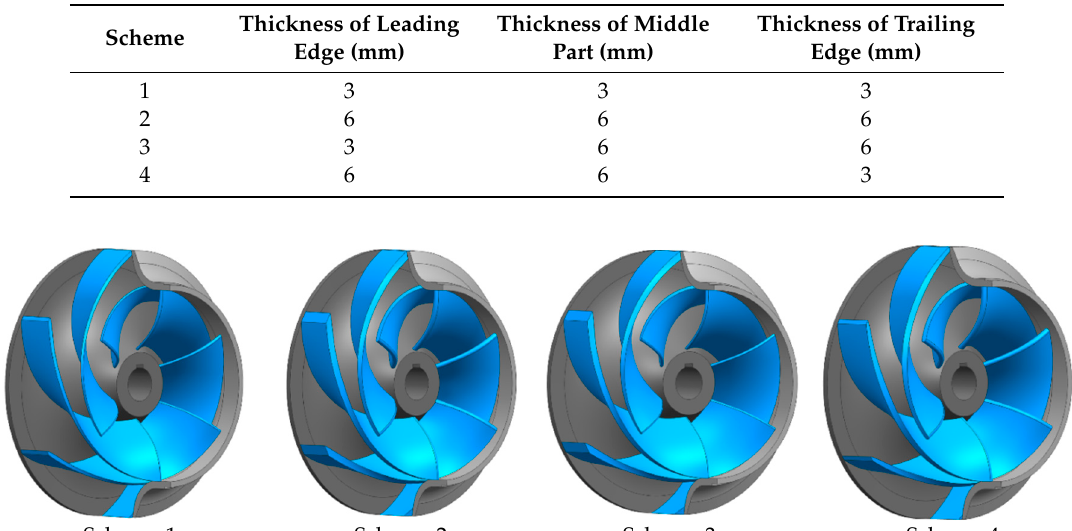
Table 2. Blades with different thickness distributions.